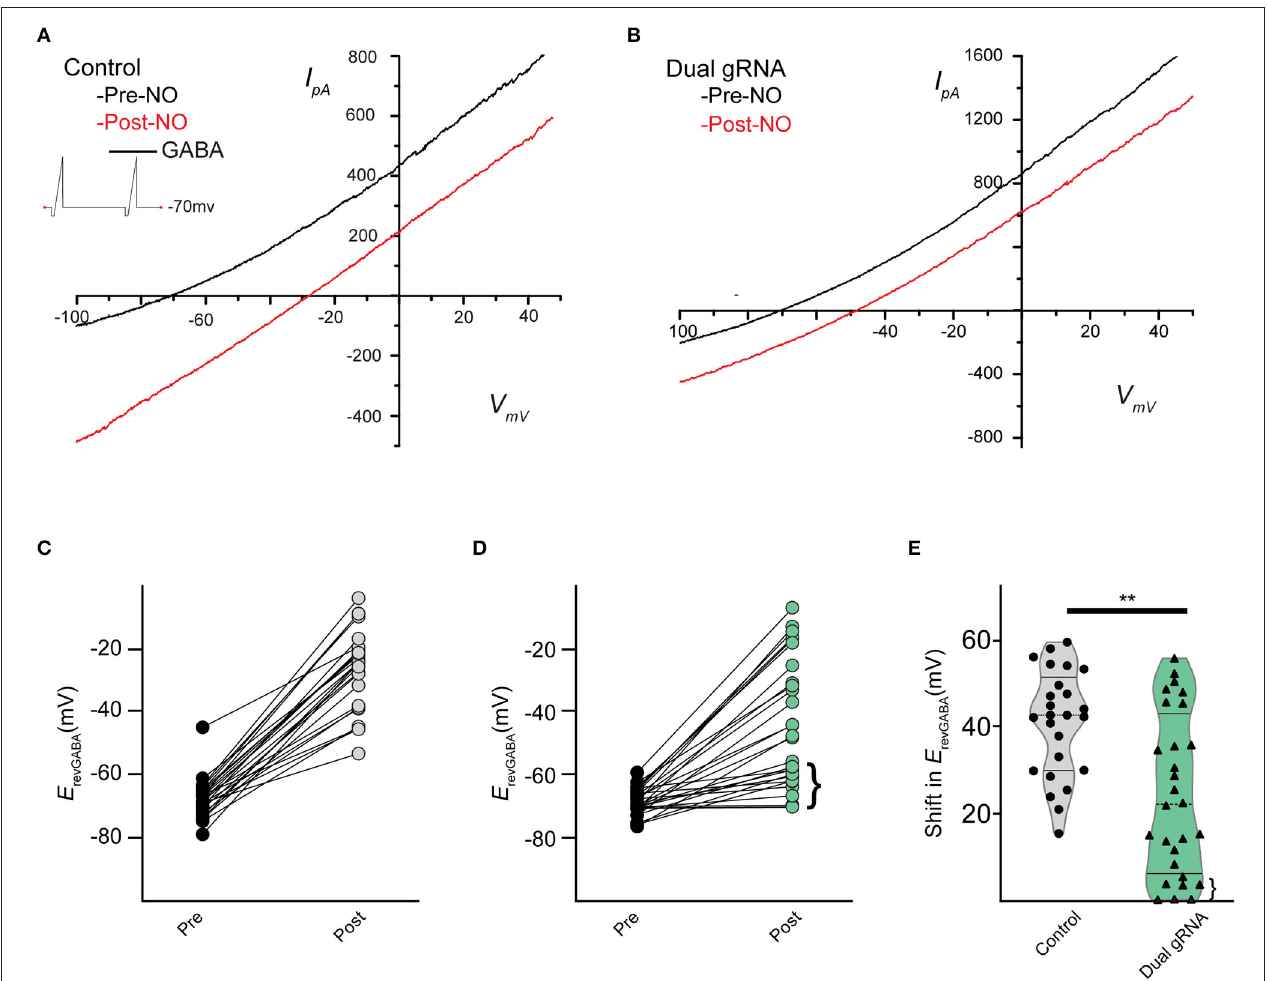
FIGURE 8 | Dual gRNA Cas9 ribonucleoproteins targeting TMEM16A reduce the NO-dependent shift in E revGABA . Recording traces from GABA-gated currents before and after injecting NO from control-transfected (A) ( n = 23) and dual gRNA/RNP-transfected cells (B) ( n = 25). Paired data showing before and after NO injection for control (C) and dual-guide RNA targeting TMEM16A (D) . Delivery of the Cas9 ribonucleoprotein led to a population of cells exhibiting significantly reduced NO-dependent shift [ (D) , brace] (E) Violin plots for the mean shift in E revGABA show a reduction under dual gRNA/RNP condition and a lower quartile [ (E) , brace] that is far lower than control (control n = 25, dual gRNA/RNP n = 28, p = 0.003, ** denotes p <